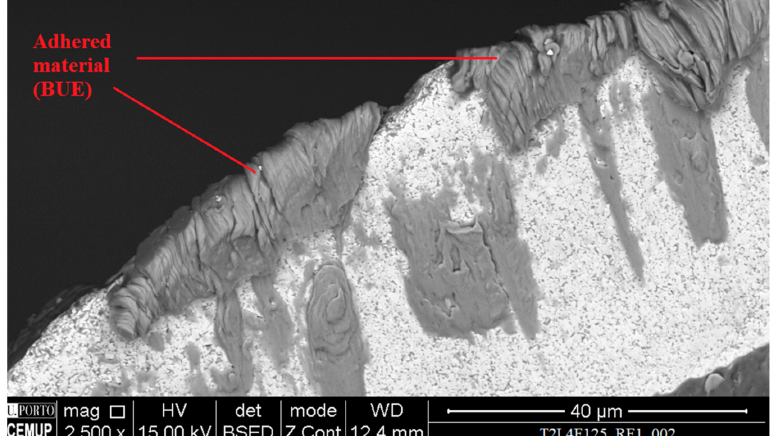
Figure 9. Rake face, with a 2500 × magnification, of the T2L4F125 tested tool, with wear mecha- nism identification.